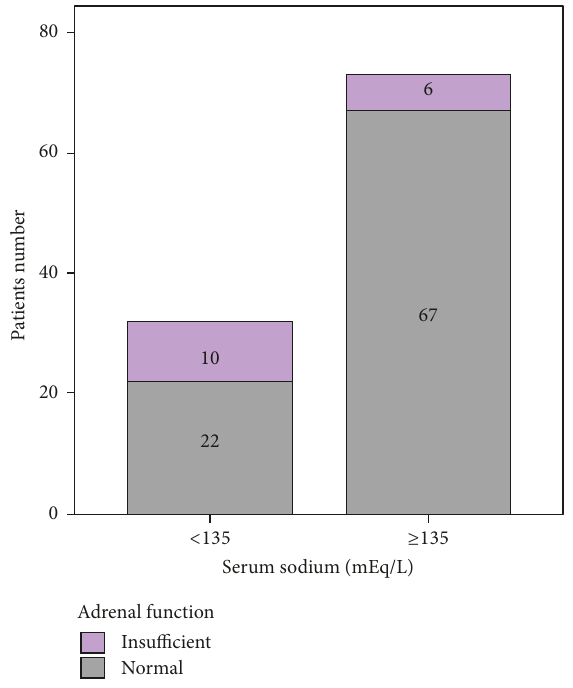
Figure 2: Adrenal function in cirrhotic patients with hyponatremia versus nonhyponatremic